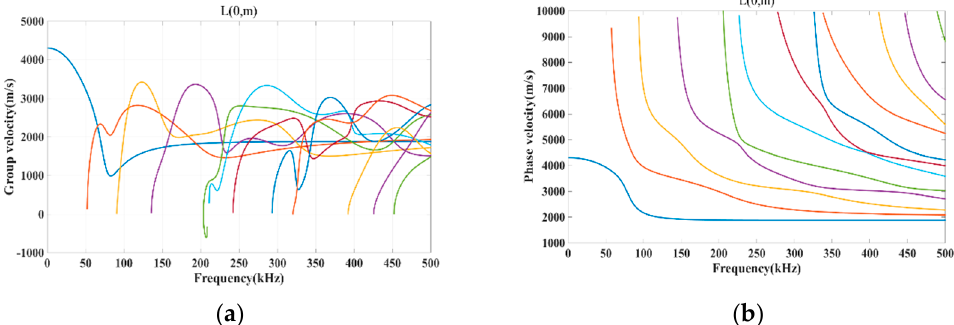
Figure 1. The dispersion curve of the concreteed concrete structure. ( a ) The group velocity dispersion curve ( b ) The phase velocity dispersion curve.